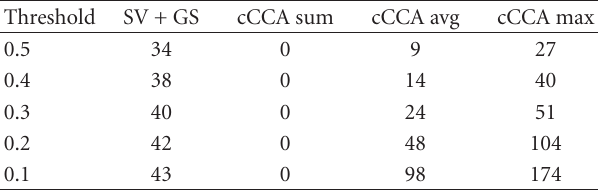
Figure 10: Number of voxels a ff ected by the smoothing artifact for two di ff erent constrained CCA methods (CCA with the average constraint (cCCA avg) and CCA with the maximum constraint (cCCA max)) as a function of the neighborhood size of the configuration. (a) is for motor data, (b) for memory data (obtained from Figures 6 and 7, resp.). Note that CCA with the max constraint leads to configurations of larger neighborhoods that need to be corrected for the smoothing artifact compared to CCA with the average constraint. The result for CCA with the sum constraint is not shown because the smoothing artifact associated with this constraint is negligible (compare Tables 1 and 2). Table 1: Number of voxels a ff ected by the smoothing artifact for di ff erent data analysis methods as a function of P > threshold in motor activation data for contrast “motor” minus “fixation”.